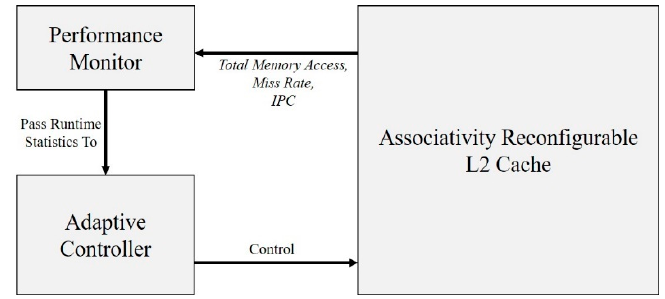
Figure 1. Architecture of adaptive reconfigurable cache.